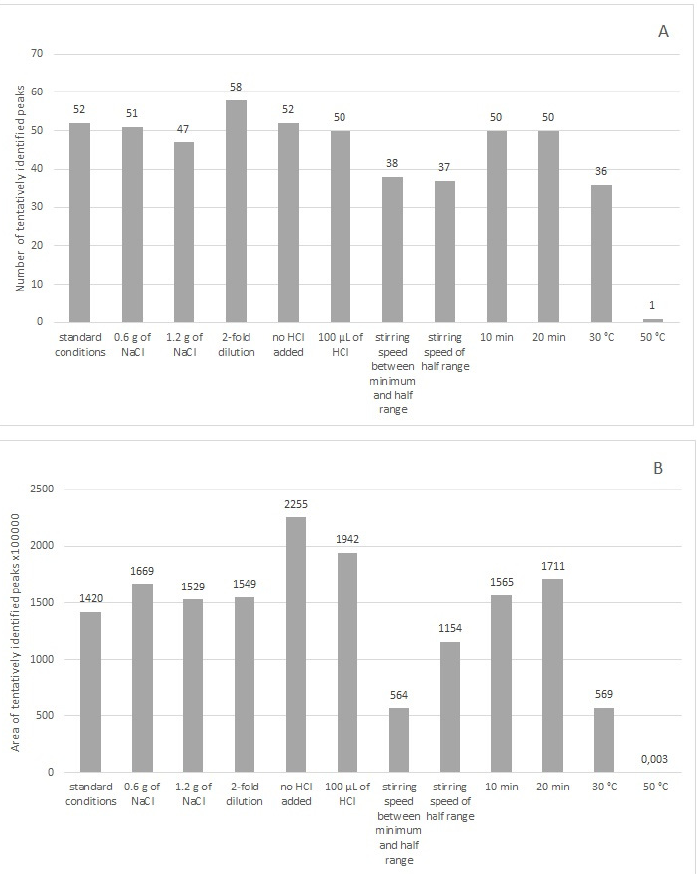
Figure 2. Comparison of the extraction efficiency of volatile compounds from Rondo wine (R2) by HS-SPME using a PA fiber under different conditions. The results are expressed as ( A ) number of tentatively identified peaks and ( B ) area of tentatively identified peaks.